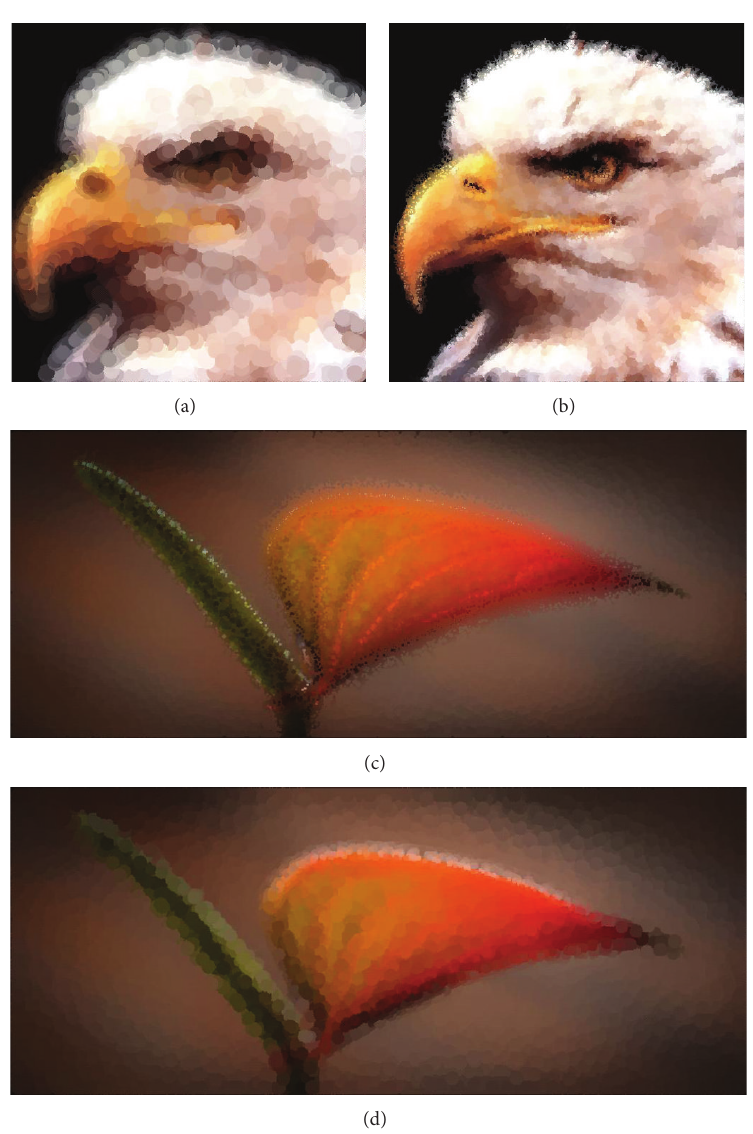
Figure 7: ((a), (c)) Pointillism without direction map and with saliency map to decide the dot size; ((b), (d)) Pointillism without direction map and with equalized standard deviation map of the saliency map to decide the dot size. All other settings are as same as those in Figures 2(d) and